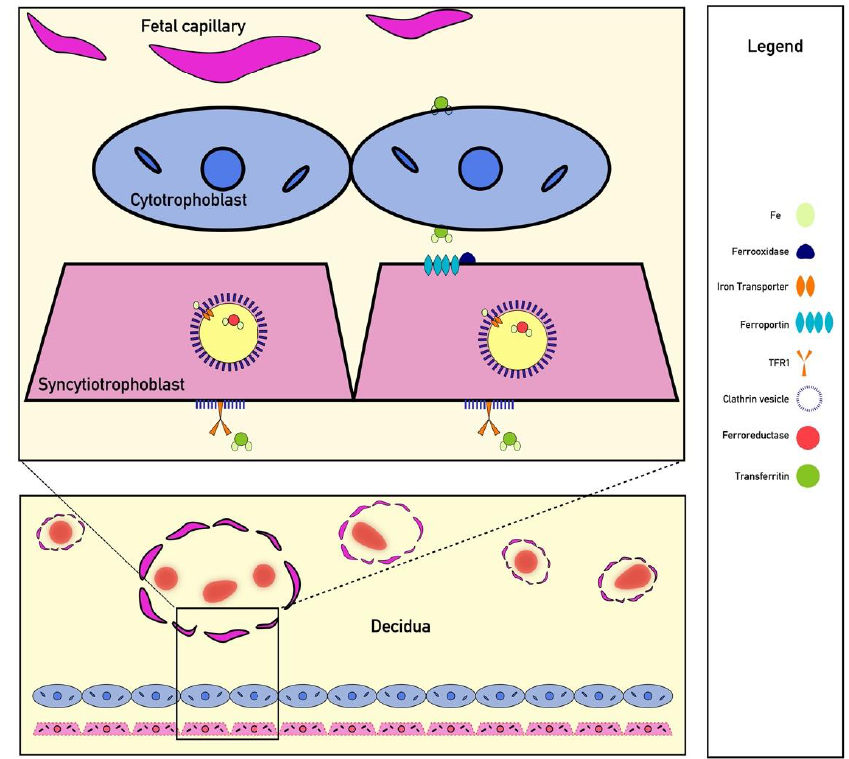
Figure 2. Iron Transport Across the Placenta. Iron is transported across the placenta by bind to TFR1 receptors on syncytiotrophoblast surrounded by clathrin-coated pits. Endocytosis of these receptors is followed by ferroportin transport. Iron is ultimately shuttled to fetal capillaries by transferrin.